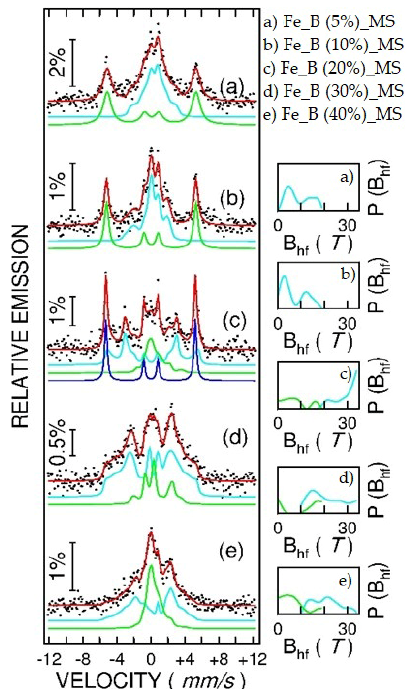
Figure 8. RT CEM spectra of Fe-B thin films obtained by MS, with the following nominal compositions of B (in at. %): 5% ( a ), 10% ( b ), 20% ( c ), 30% ( d ), 40% ( e ). The vertical bars indexes the effect of the spectra (in %). The probability distributions of the hyperfine magnetic field are shown on the right hand of the spectra The black dots are experimental points, the blue and green continuous lines provide the spectral components discussed in the text, whereas the red lines represent the total spectral envelope given by the fit.